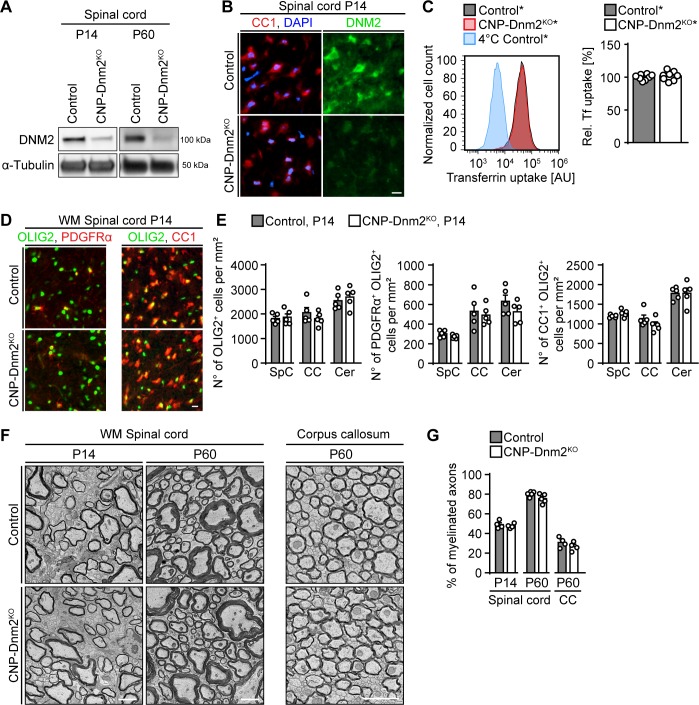
Oligodendrocytes can differentiate and myelinate without dynamin 2.(A) Immunoblot analysis of DNM2 in spinal cord extracts from Dnm2loxP/loxP (control) and CnpCre: Dnm2loxP/loxP (CNP-Dnm2KO) mice (P14, P60). N = 4 mice/genotype. Quantification in Figure 5—figure supplement 1B, full-length blot in Supplementary file 1C. (B) Exemplary transverse sections of ventral horn region of lumbar spinal cord from control and CNP-Dnm2KO mice at P14, double-stained for CC1 (red; mature oligodendrocyte (OL) marker) and DNM2 (green), showing DNM2 ablation in mutant OLs. N = 3 mice/genotype. Scale bar = 10 μm. (C) Representative experimental set (left) and quantified sets (right) of FACS analyses of transferrin (Tf) uptake on primary mouse OLs derived from CnpCre:Rosa26-stoploxP/loxP-YFP (control*) and CnpCre:Dnm2loxP/loxP:Rosa26-stoploxP/loxP-YFP (CNP-Dnm2KO*) P7 brain (14 days in culture). CNP-Dnm2KO OLs show no detectable difference in Tf uptake compared to controls (note the virtually complete overlap of the corresponding peaks). Control average is set to 100. N = 8 mice/genotype, two-tailed unpaired Student’s t-test. (D) Representative immunostainings of control and CNP-Dnm2KO in white matter (WM) ventral spinal cord cross-sections for OLIG2 and PDGFRα (left panel) or OLIG2 and CC1 (right panel) at P14. N = 5 mice/genotype. Scale bar = 10 μm. (E) Quantification of (D) (Spinal cord (SpC) ventrolateral WM hemisection, corpus callosum (CC) midbody, and cerebellum (Cer) lobes IV,V). Total OL lineage cells (OLIG2+), OPC (PDGFRα+ OLIG2+) and mature OL (CC1+ OLIG2+) in SpC ventrolateral WM, corpus callosum (CC), and cerebellum (Cer) of control and CNP-Dnm2KO mice. N = 5 mice/genotype, two-tailed unpaired Student’s t-test. (F) Exemplary EM images showing ultrastructure of control and CNP-Dnm2KO ventral SpC WM (P14, P60) and CC (P60). Scale bars = 2 μm. (G) Quantification of (F) (random fields). Percentages of myelinated fibers in SpC ventral WM (P14, P60) and corpus callosum (P60). At least 752 axons/animal were analyzed. N = 4–5 control and mutant mice at the indicated time points, two-tailed unpaired Student’s t-test. Results in graphs represent means ±s.e.m.